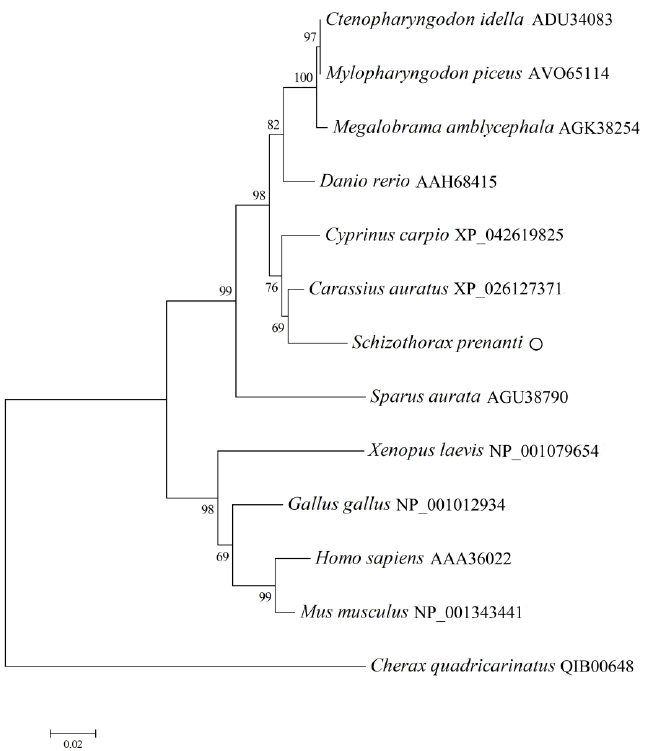
Figure 4. Phylogenetic tree of HSP60 amino acids from different vertebrates: ○ indicates Sp HSP60; the GenBank accession numbers of other vertebrates are marked.